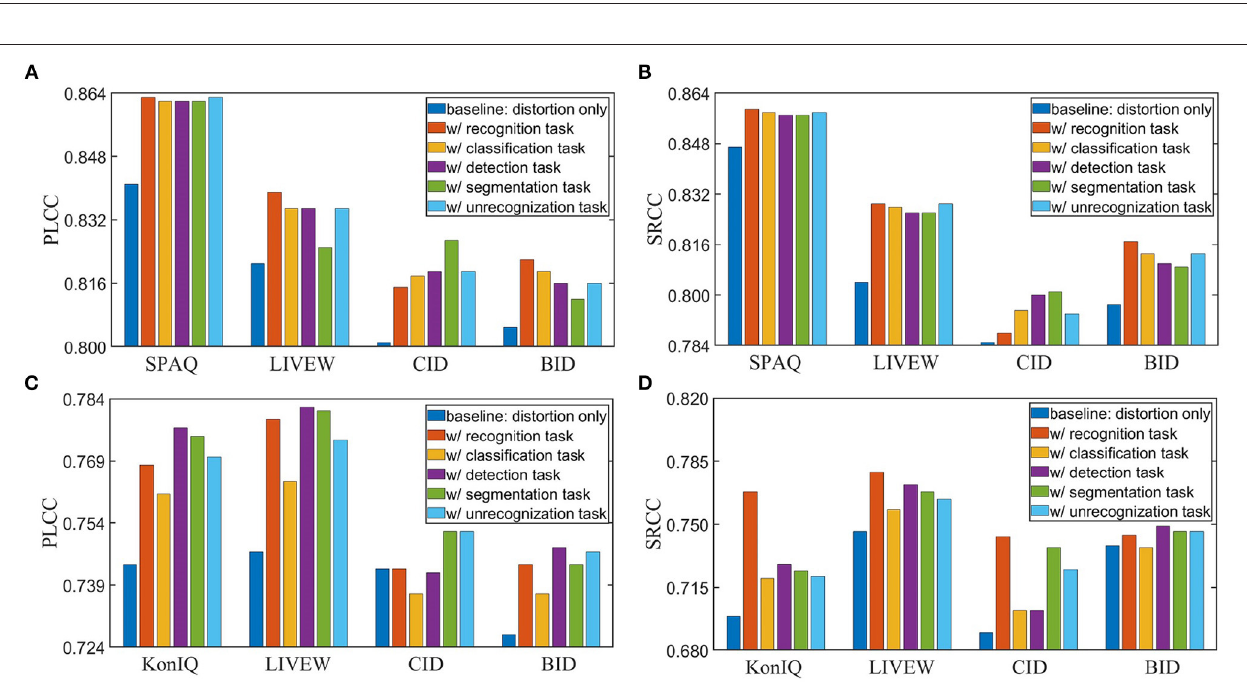
FIGURE 6 | Ablation study of intelligibility enriched IQA (IE-IQA). (A) Pearson’s linear correlation coefficient (PLCC) results of models trained with 80% KonIQ-10k. (B) Spearman’s rank order correlation coefficient (SRCC) results of models trained with 80% KonIQ-10k. (C) PLCC results of models trained with 80% Smartphone Photography Attribute and Quality (SPAQ). (D) SRCC results of models trained with 80% SPAQ.